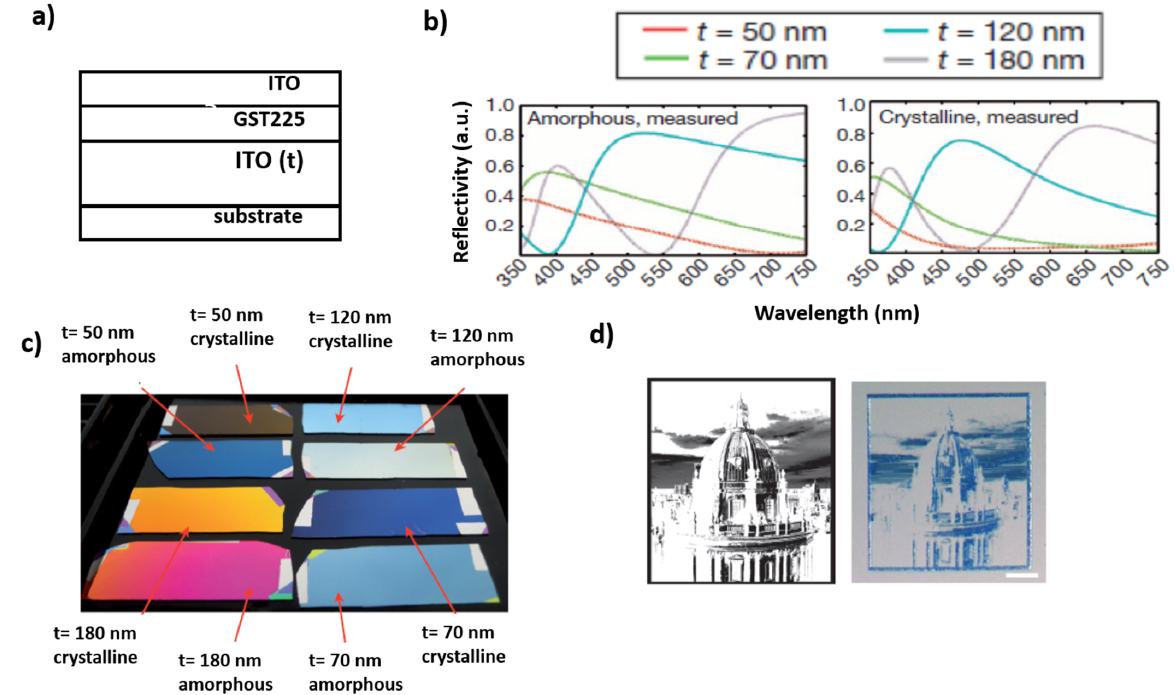
Figure 3. ( a ) Scheme of the structure proposed by Hosseini et al. [32] to obtain a colored display; ( b ) variation of the Reflectivity spectrum of a device consisting of 10 nm ITO/7 nm GST225/t ITO/Pt mirror, with different thickness t, upon phase transition; ( c ) optical pictures of different devices consisting of 10 nm ITO/7 nm GST225/t ITO/Pt mirror, with different t, in different phases; ( d ) employment of a 10 nm ITO/7 nm GST225/70 nm ITO/Pt mirror device for the reproduction and storage of a greyscale picture of the Oxford Radcliff Camera (original picture shown in the left). Clear regions correspond to amorphous GST225, dark blue regions correspond to crystalline GST225. Scale bar is 10 μm. Reproduced from Ref. [32] with permission from Nature Springer.